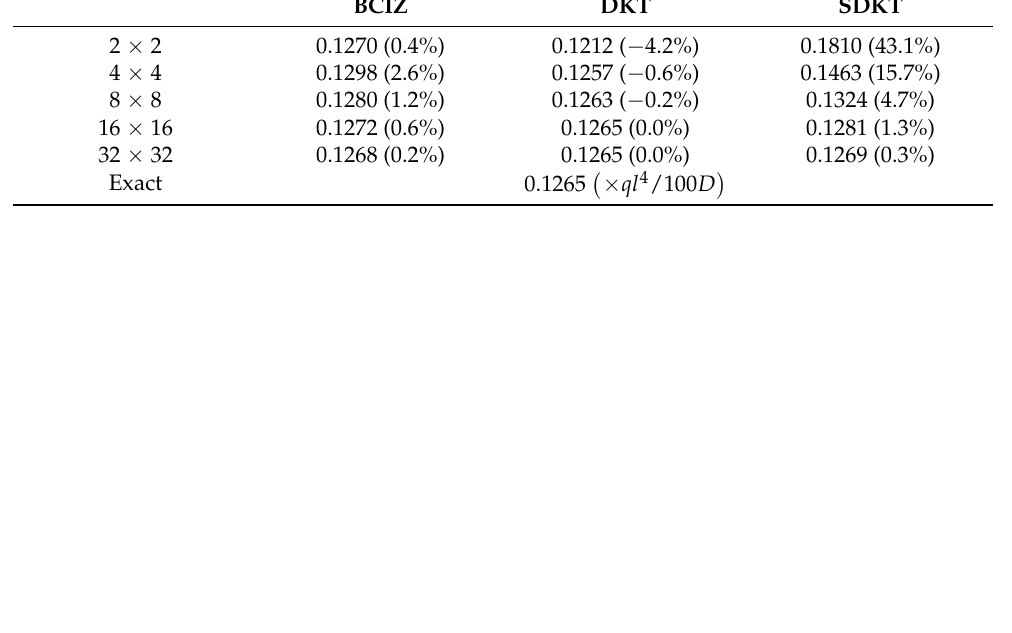
Table 2. Central deflection for a simply supported square plate under uniform load.